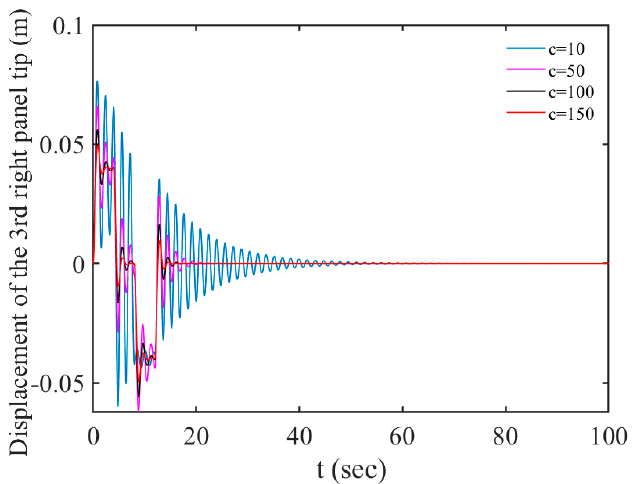
Figure 10. The vibration response of the system with various values of c ( k = 500 N · m/rad).